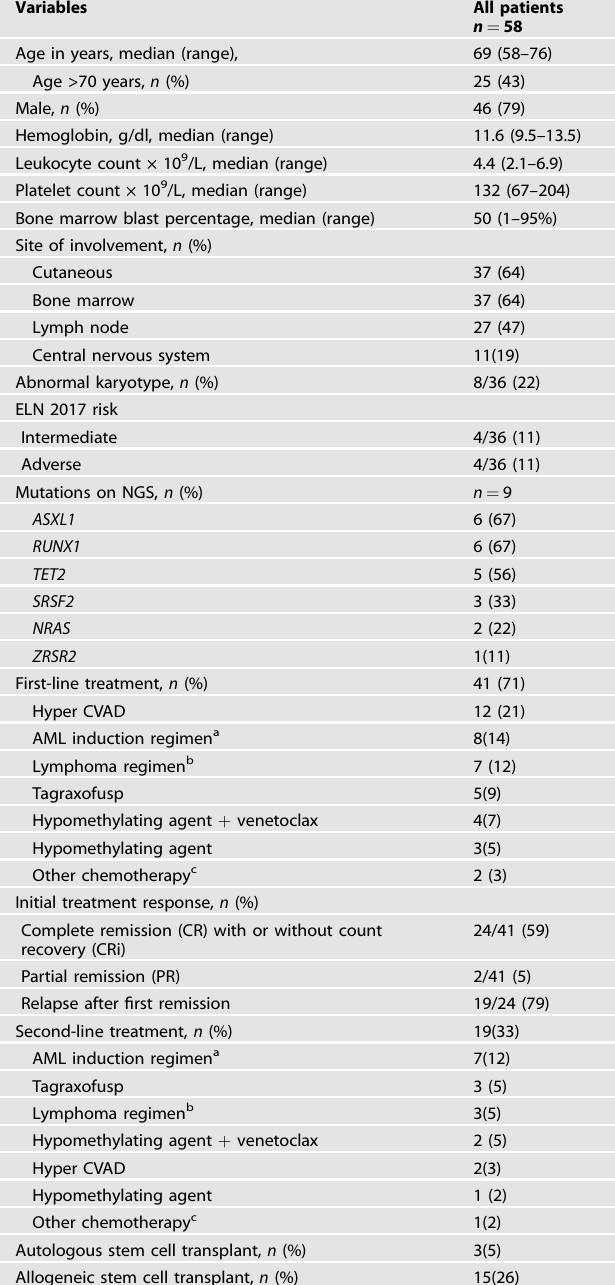
Table 1. Presenting clinical and laboratory characteristics and treatment details of 58 adult patients with blastic plasmacytoid dendritic cell neoplasm. Variables All patients